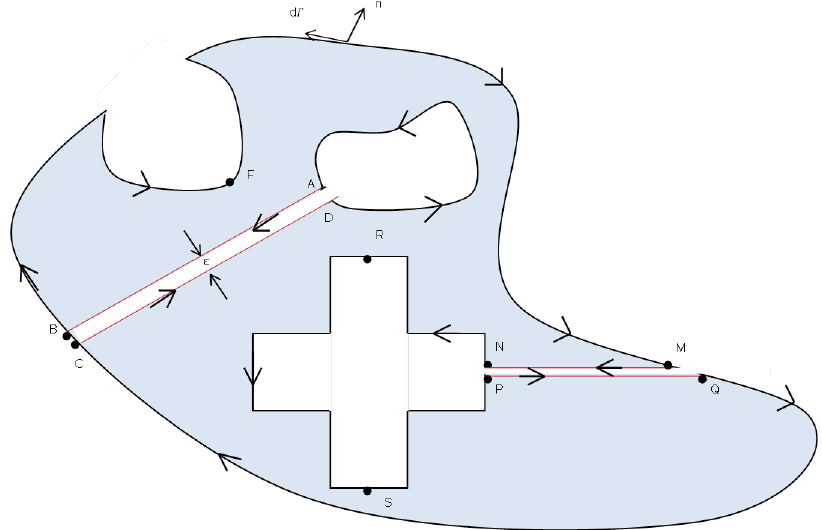
Figure A1. The reservoir from the perspective of Region 8.